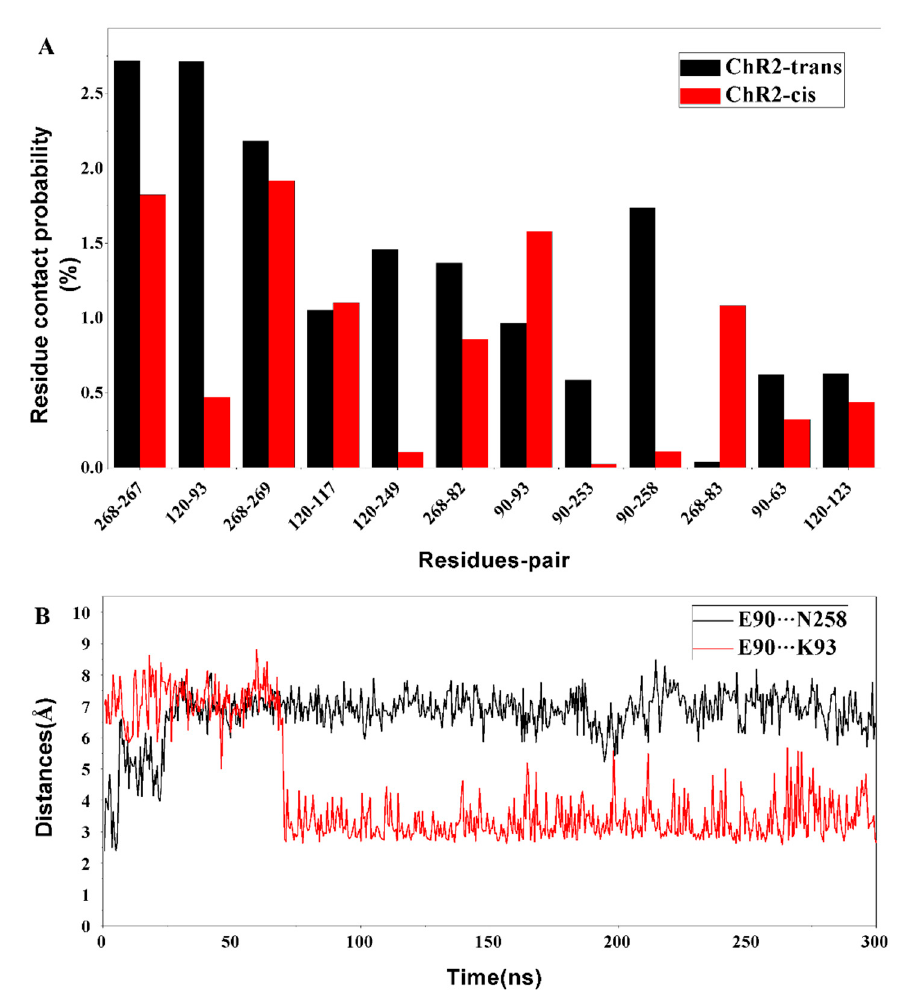
Figure 6. ( A ) The probability of contact among the key residues surrounding the channel in the equilibrium trajectories of ChR2-trans and ChR2-cis. ( B ) The hydrogen bond distance between E90 and N258 (black), as well as E90 and K93 (red) during the whole trajectory of ChR2-cis, the distance between E90 and N258 increases and the hydrogen bonding disappears; the distance between E90 and K93 is close to form a new hydrogen bond interaction.